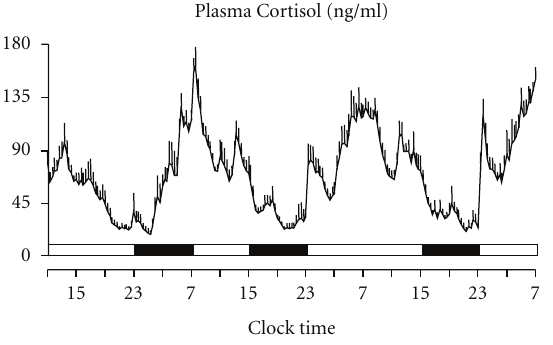
Figure 4: E ff ect of an 8-hour sleep advance on cortisol profiles. Mean (+ SEM) cortisol profiles obtained during 68 consecutive hours including baseline conditions and 2 postshift periods, that is, after an 8-hour advance of the sleep-wake and dark-light cycles. Black bars represent the sleep periods whereas wake time was spent in dim light conditions. (Adapted from Caufriez et al.